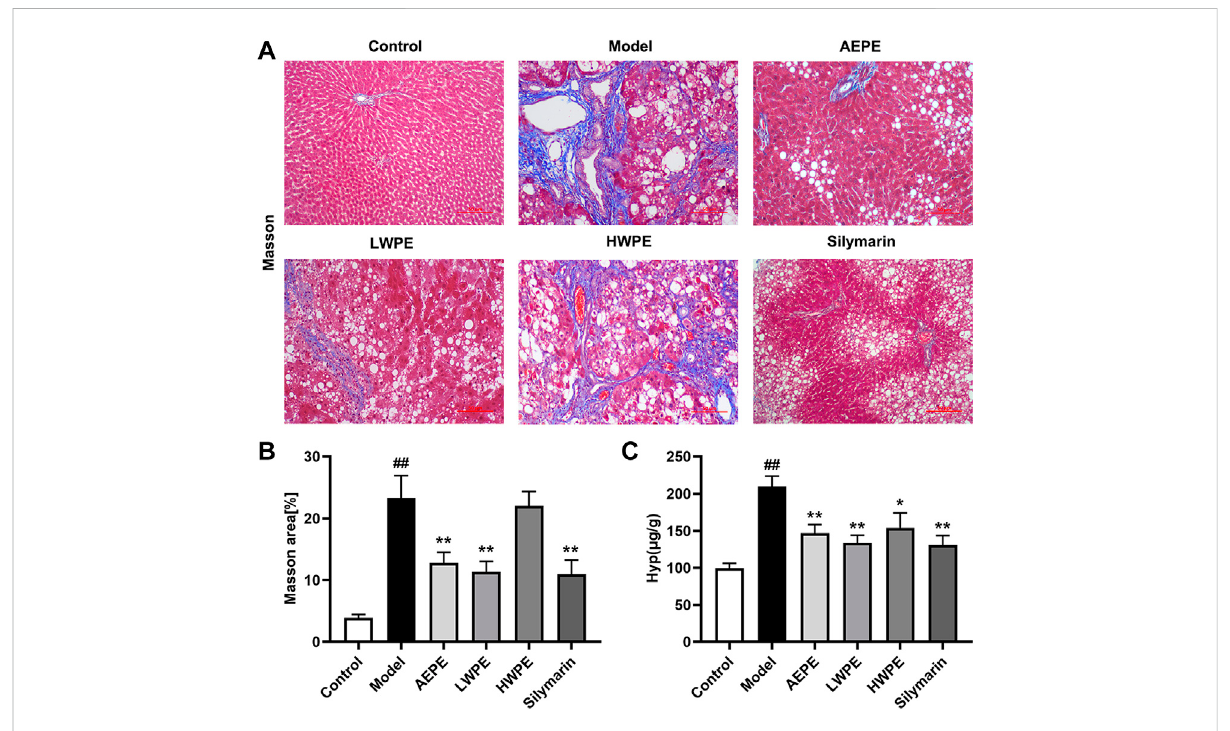
FIGURE 4 Effects of AEPE and its fractions on liver fi brosis in rats administered with CCl 4 . (A) Representative rat livers stained with Masson (magni fi cation,×200). (B) ThepositiveregionsofMassonstaining. (C) Hypcontentsinlivertissues. Dataareexpressedasthemean±SEM( n =7 – 10).